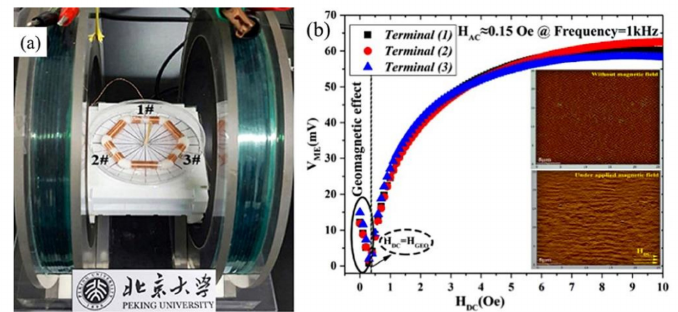
Figure 11. ( a ) The structure of the HFMEC. ( b ) ME coupling response of the HFMEC as a function of the DC magnetic-field, the signal exhibits a “V” shape and the knee point of the curve reveals the geomagnetic field